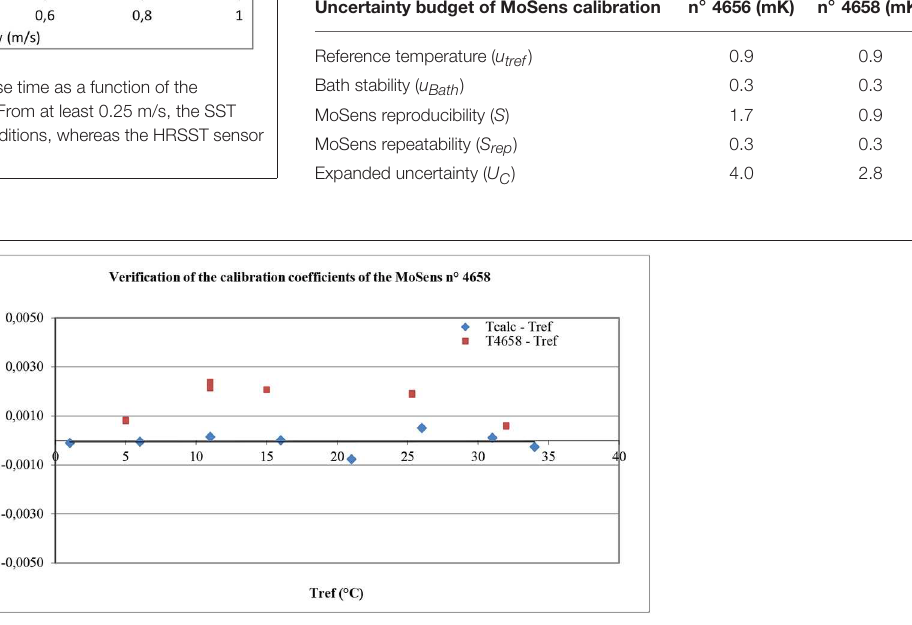
FIGURE 4 | Example of calibration verification made on the MoSens sensor n ◦ 4658. Blue squares represent the residuals and the red squares represent the measured values after the calibration.